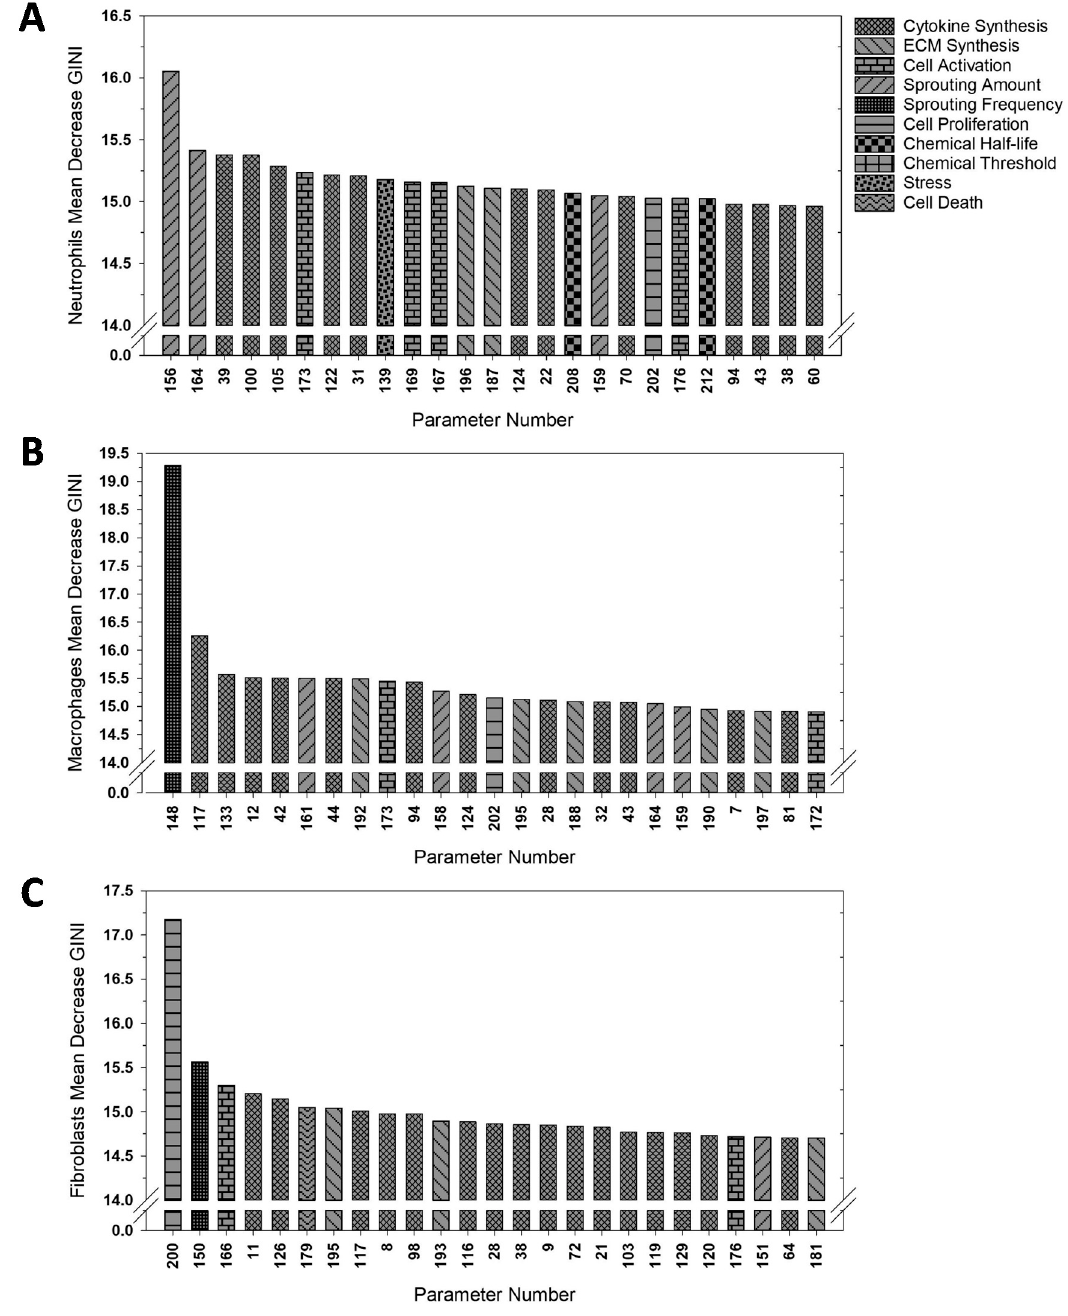
Figure 3. Top 25 most influential parameters for Day 1. ( A ) Neutrophils; ( B ) Macrophages; ( C ) Fibroblasts. The biological function of each parameter is coded by the shade of the bar.